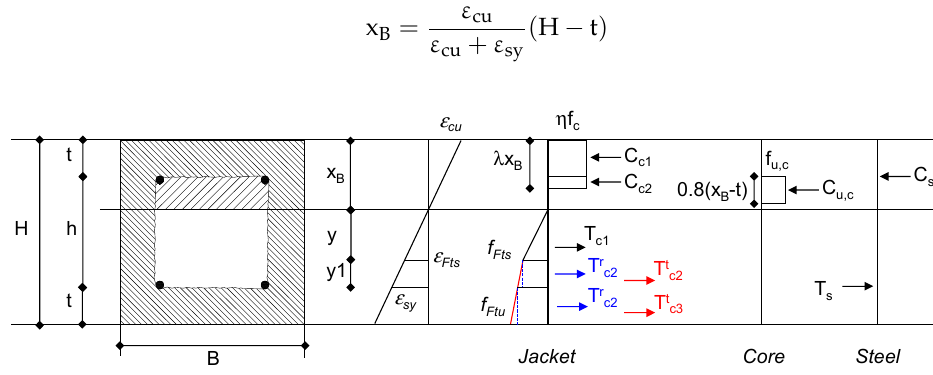
Figure 17. Equilibrium of the internal forces acting on the cross-section (balanced failure).